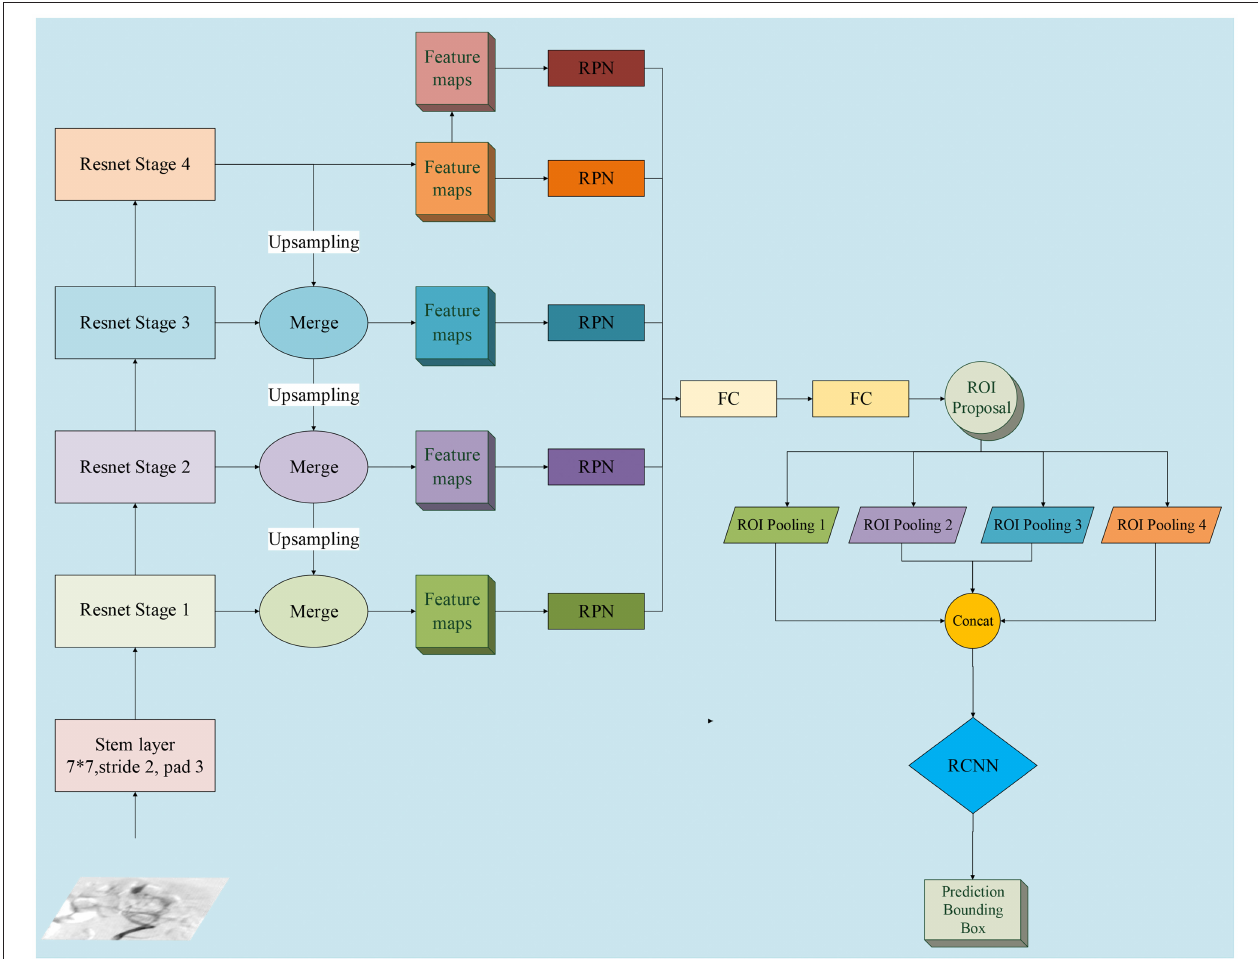
FIGURE 2 | Detailed network structure diagram of feature pyramid network (FPN). We adopted FPN with a ResNet-50 backbone for InterNet. FPN is an outstanding detector for many visual tasks and can identify objects at multi-scales. RPN, region proposal network; ROI, region of interest; FC, fully connected layer; bbox, bounding box; RCNN, Region Based Convolutional Neural